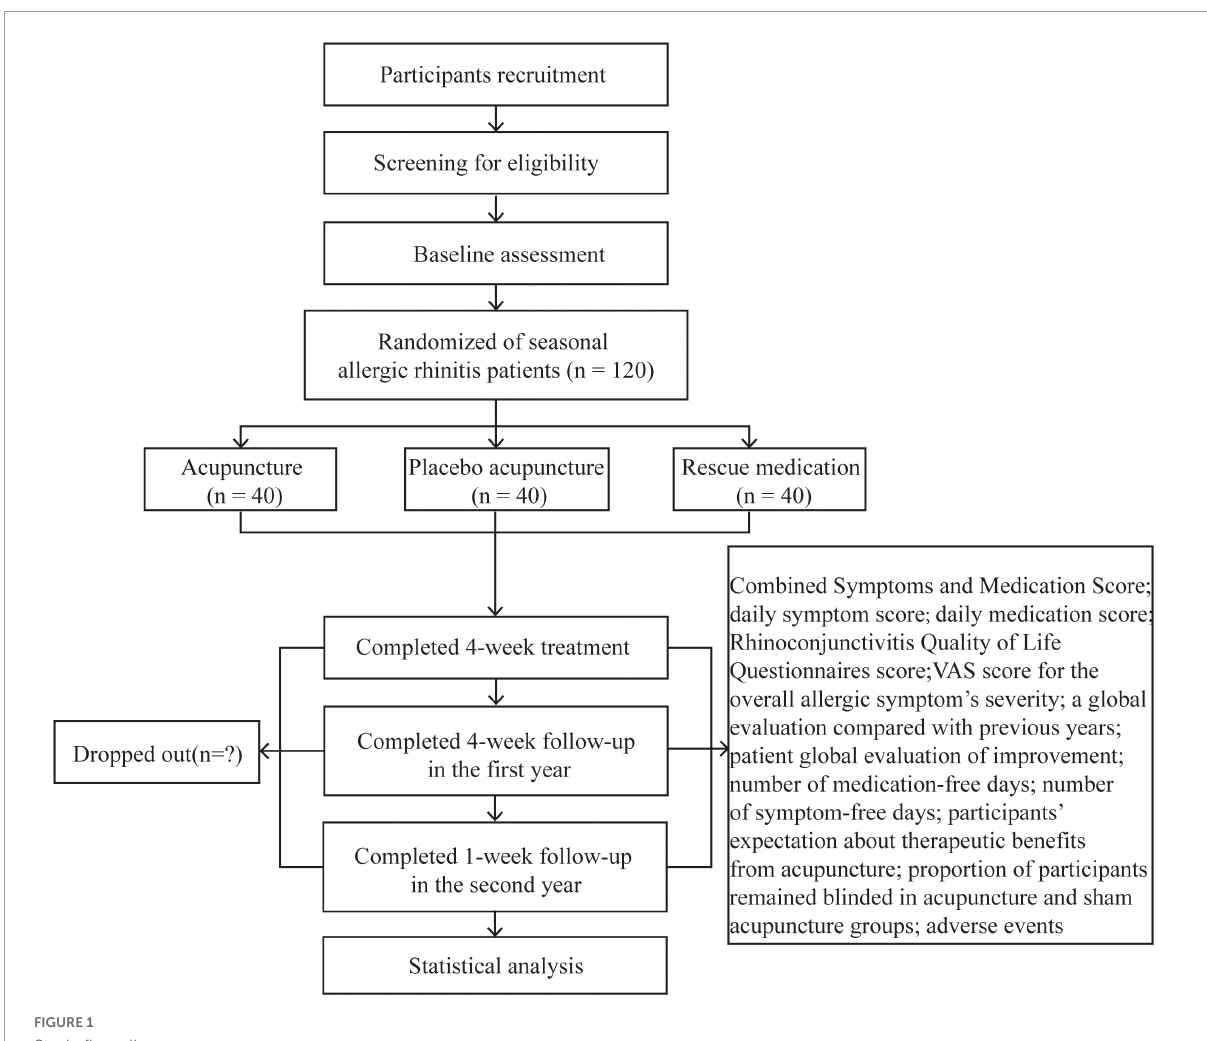
FIGURE1 Study flow